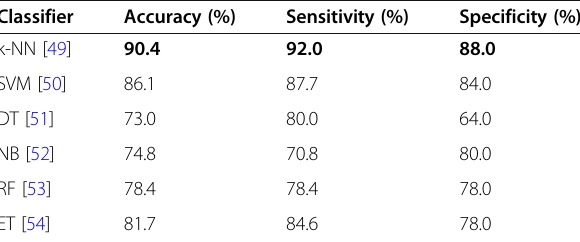
Table 14 Classification results obtained for six different state-of- the-art classifiers using a set of nine most discriminative